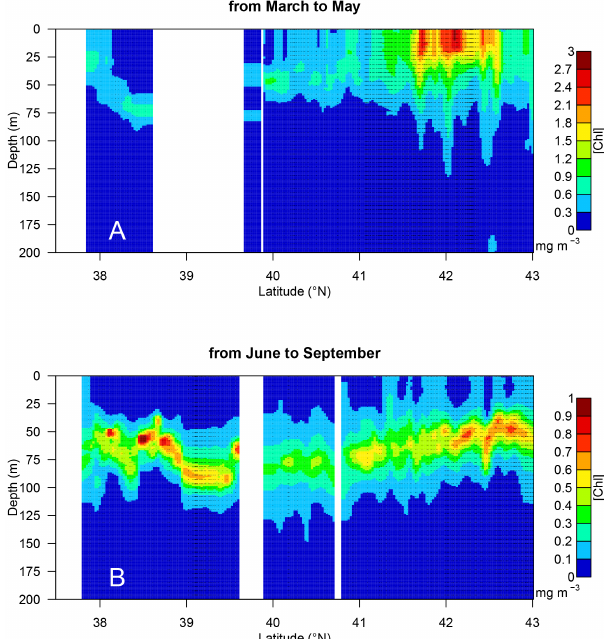
Figure 4. North–south climatological transect of [Chl a ] along the 5 ◦ W meridian (see the black dotted line in Fig. 1). Panel (a) rep- resents the averaged situation for the March to May period, and (b) does so for the June to September period. Note that color scales are different in (a) and (b) . For each available data profile, a vertical dotted line was superimposed on the